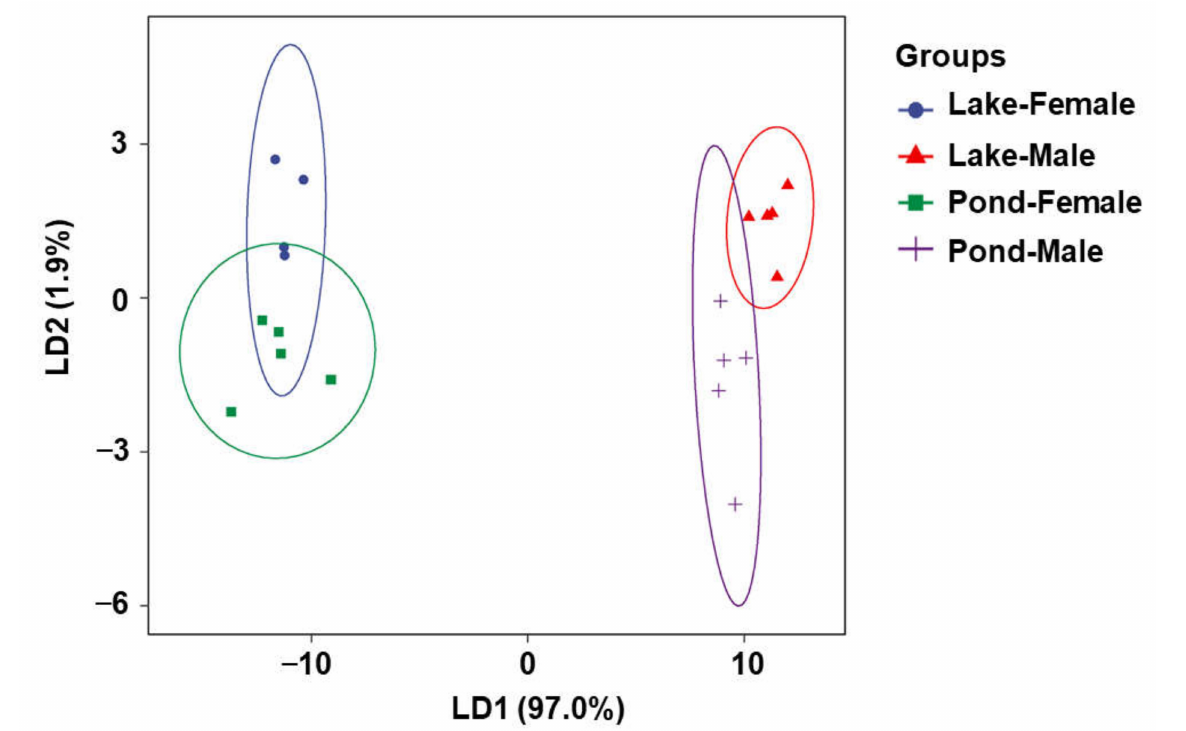
Figure 3. Discriminant function analysis of the taste values of umami, aftertaste-U, bitterness, aftertaste-B, astringency, and aftertaste-A in the hepatopancreas of June hairy